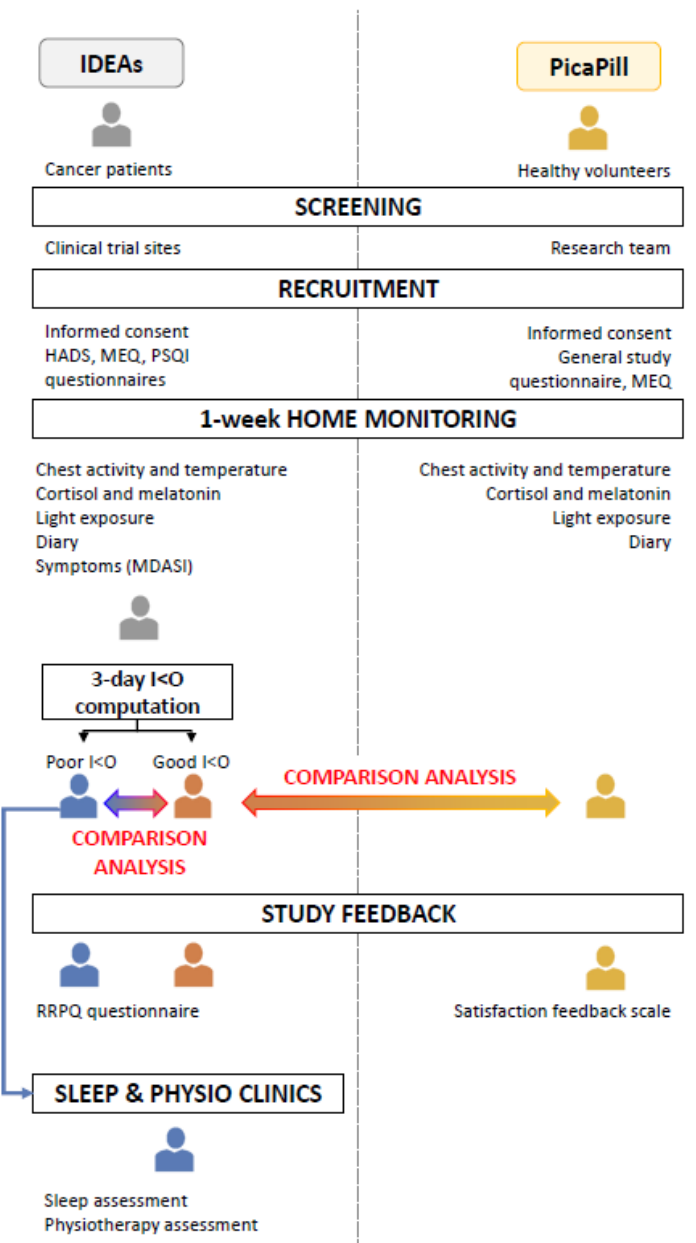
Figure 8. Study design. Chart showing the similar study designs for cancer patients (IDEAs) and controls (PicaPill). HADS: hospital anxiety and depression scale; MEQ: Morningness-Eveningness Questionnaire; PSQI: Pittsburgh sleep quality index; MDASI: M.D. Anderson Symptom Inventory; RRPQ: reactions to research participation questionnaire.